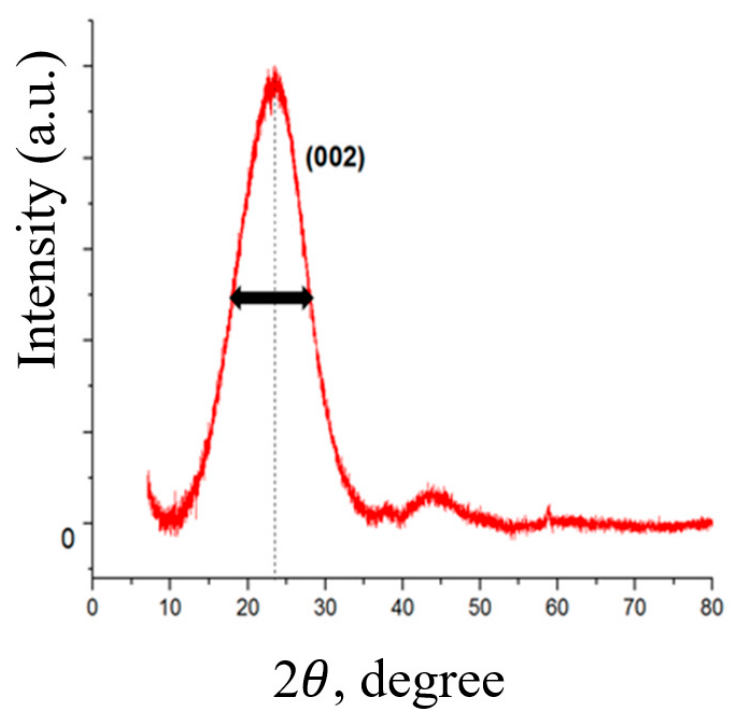
Figure 6. Results of X-ray spectroscopy studies of the synthesized FLG of graphene nanostructures. Typical diffractogram.